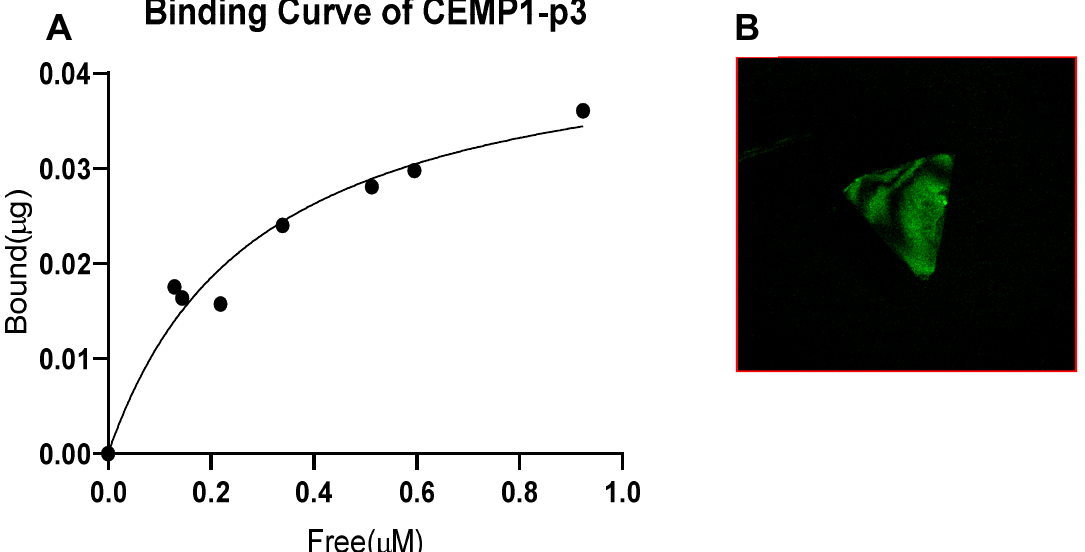
Figure 4. ( A ) Binding isotherm for CEMP1-p3. The quantity that bounds to the surface of the crystal (Bound, µ g) is plotted as a function of the free concentration (Free, µ M) to obtain the isotherm. ( B ) CLSM observation of Alexa Fluor 488-labeled CEMP-p3 binding to OCP surface.